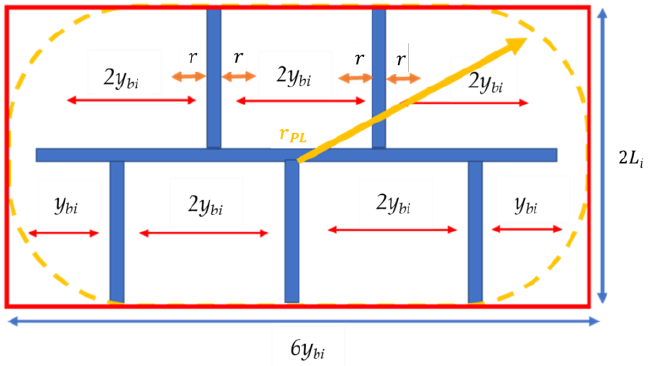
Figure 6. The outer and inner region representation of the stimulated volume for a Fishbone well.